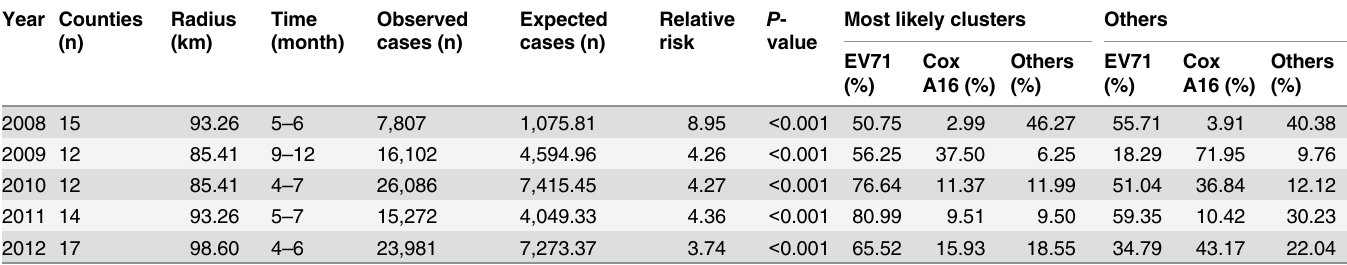
Table 5. The scanning results of space-time cluster analysis for mild cases of HFMD from Zhejiang Province, 2008 – 2012. Year Counties Radius (n) (km)